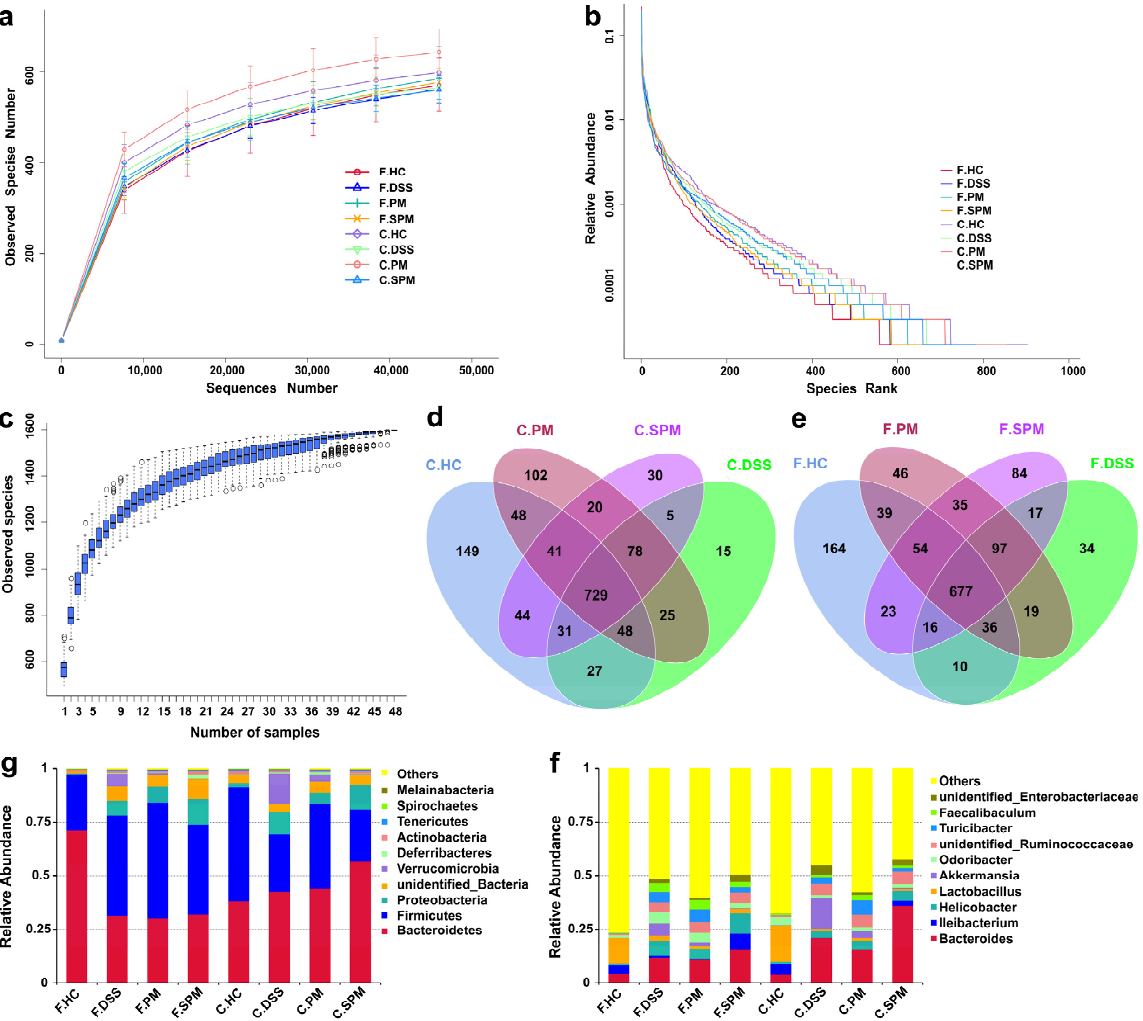
Figure 6. Sample complexity analysis and species distribution of the gut flora in mice. ( a ) Rarefaction curve; ( b ) Rank abundance curve; ( c ) Species accumulation boxplot; ( d ) OTUs Venn diagram of cecum contents; ( e ) OTUs Venn diagram of feces; ( g ) Relative abundance of species at the phylum level; ( f ) Relative abundance of species at the genus level. F, Feces; C, Cecum contents.